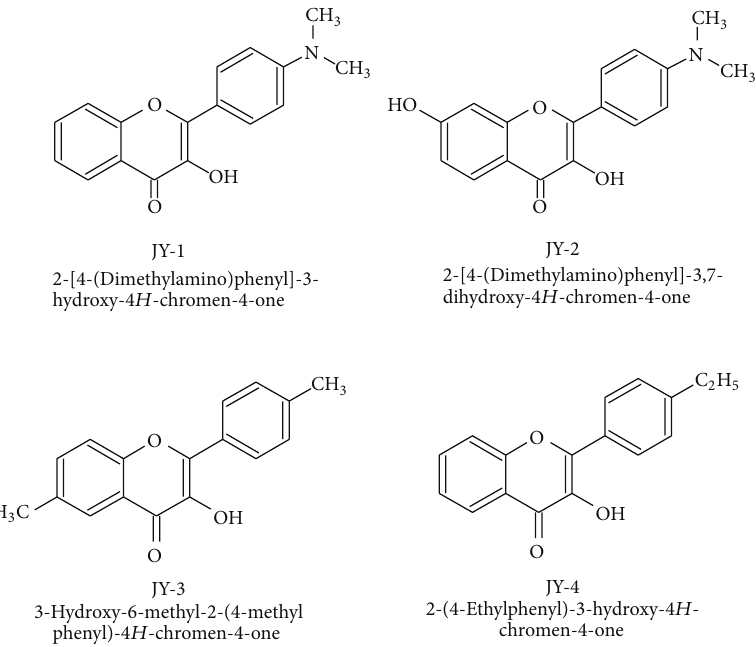
Figure 1: Structures of selected benzopyrone analogues (JY-1, JY-2, JY-3, and